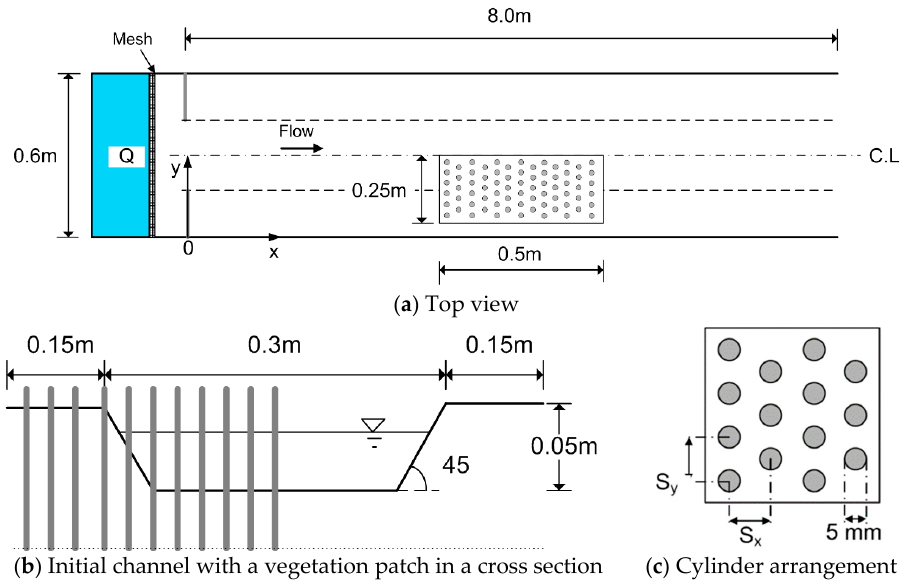
Figure 1. Schematic diagram of the experimental flume.